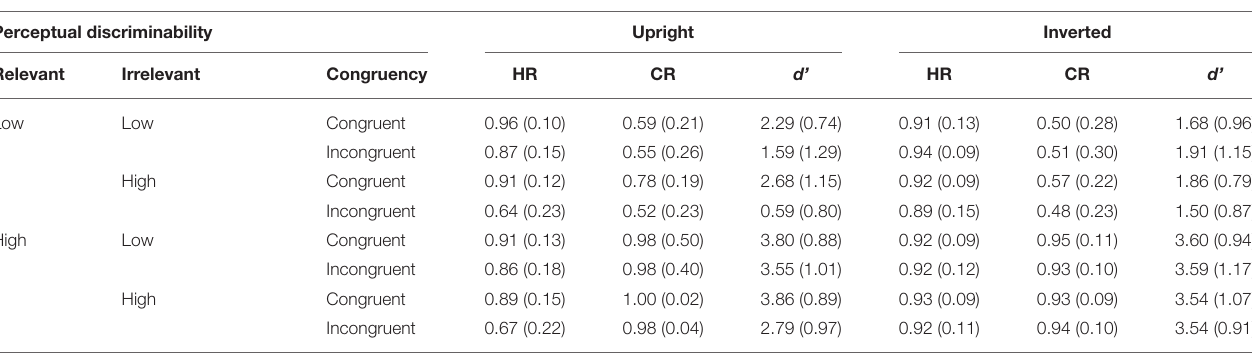
TABLE 1 | Descriptive statistics for each condition in Experiment 1 ( N = 29).